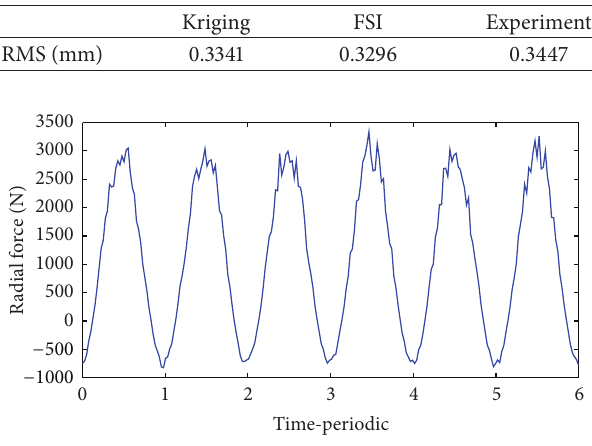
Figure 7: The radial force of the pump impeller.